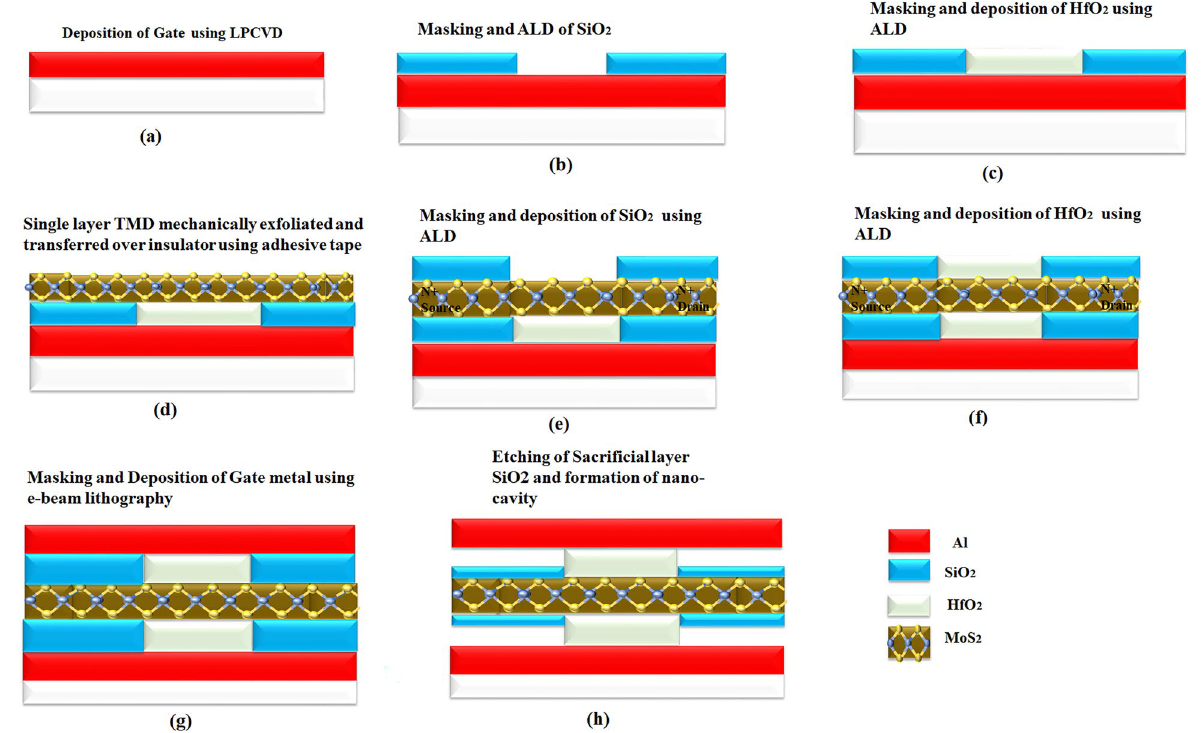
Figure 3. Proposed fabrication process of the DM-DG-TMD-FET-based biosensor.